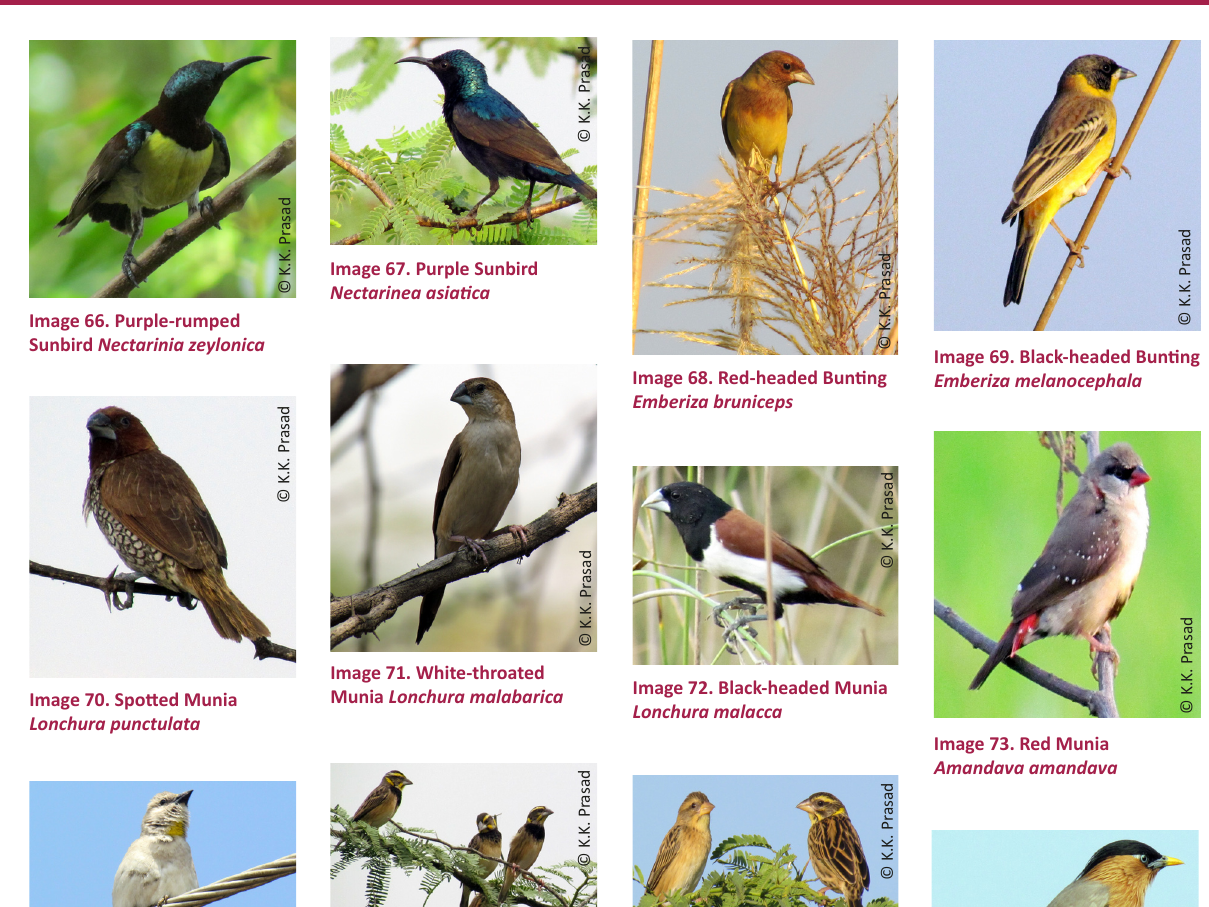
Image 76. Streaked Weaver Ploceus manyar